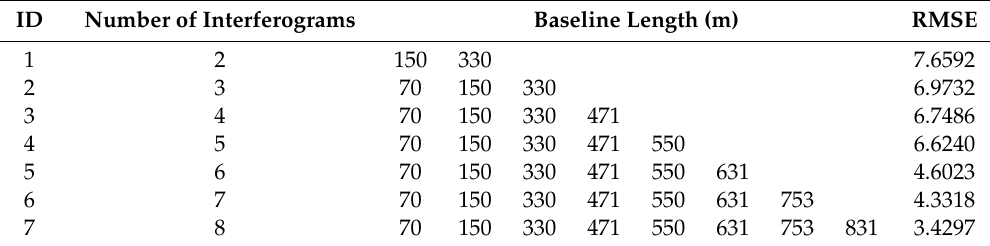
Table 3. The relationship between the estimation RMSE of TSPA-PUMA and the number of interferograms. ID Number of